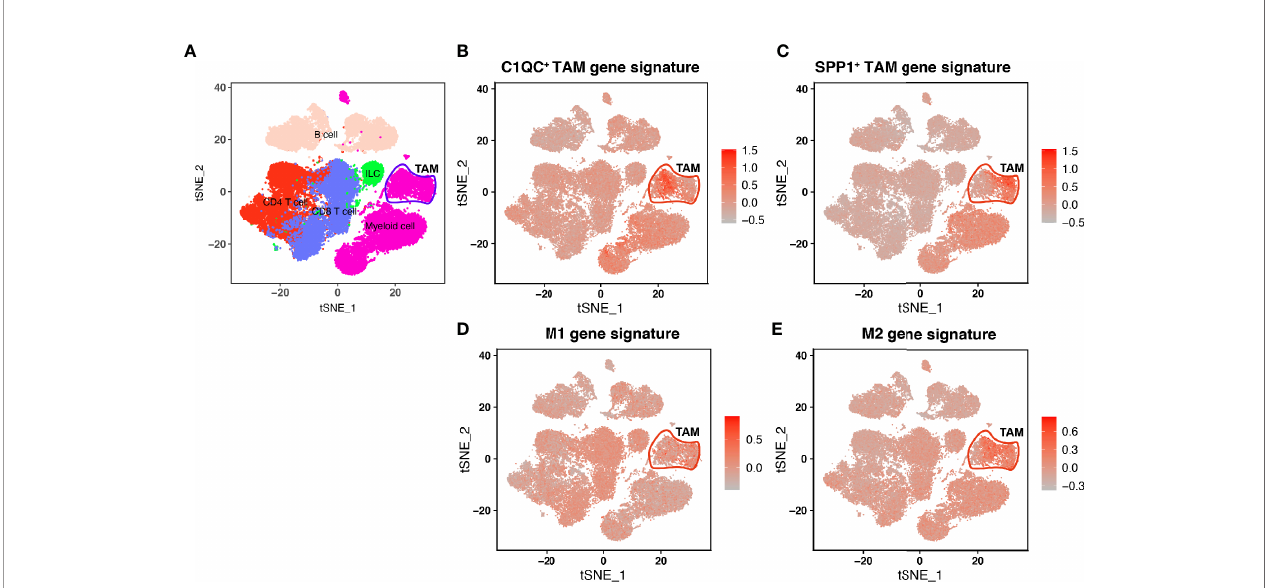
FIGURE 1 | Single-cell transcriptome pro fi ling and TAM gene signatures of the Human CRC TME. (A) tSNE plot showing major immune cell subsets in human CRC TME. (B) tSNE plot of all immune cells colored by enrichment of C1QC + TAM gene signatures. (C) tSNE plot of all immune cells colored by enrichment of SPP1 + TAM gene signatures. (D) tSNE plot of all immune cells colored by enrichment of M1 gene signatures. (E) tSNE plot of all immune cells colored by enrichment of M2 gene